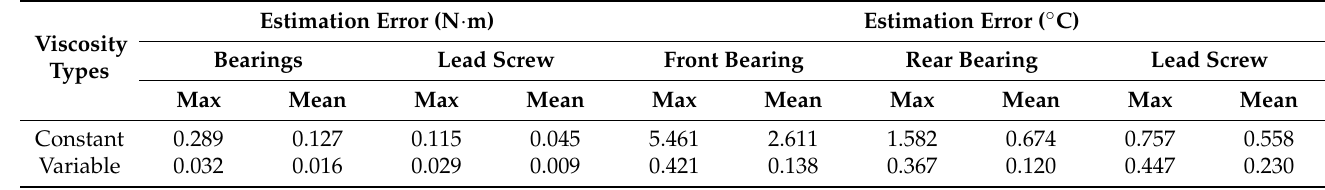
Table 6. Comparisons of estimation errors of the fluid friction calculation model.